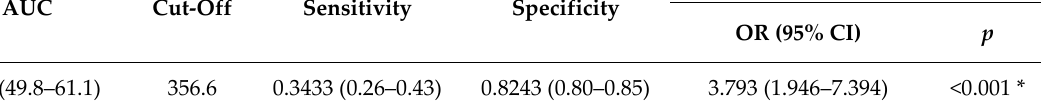
Figure 3. Receiver operating characteristics (ROC) curve for PLR as a predictive factor of Figure COVID-19 mortality.